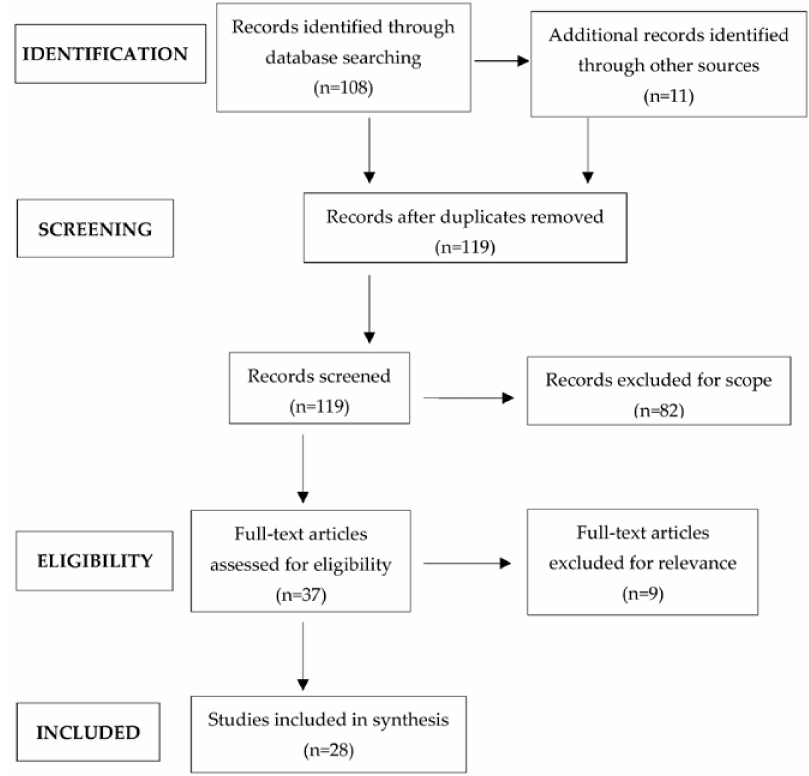
Figure 1. PRISMA flow chart for search